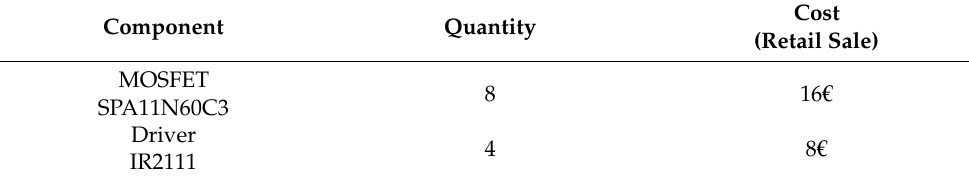
Table 4. Si resonant